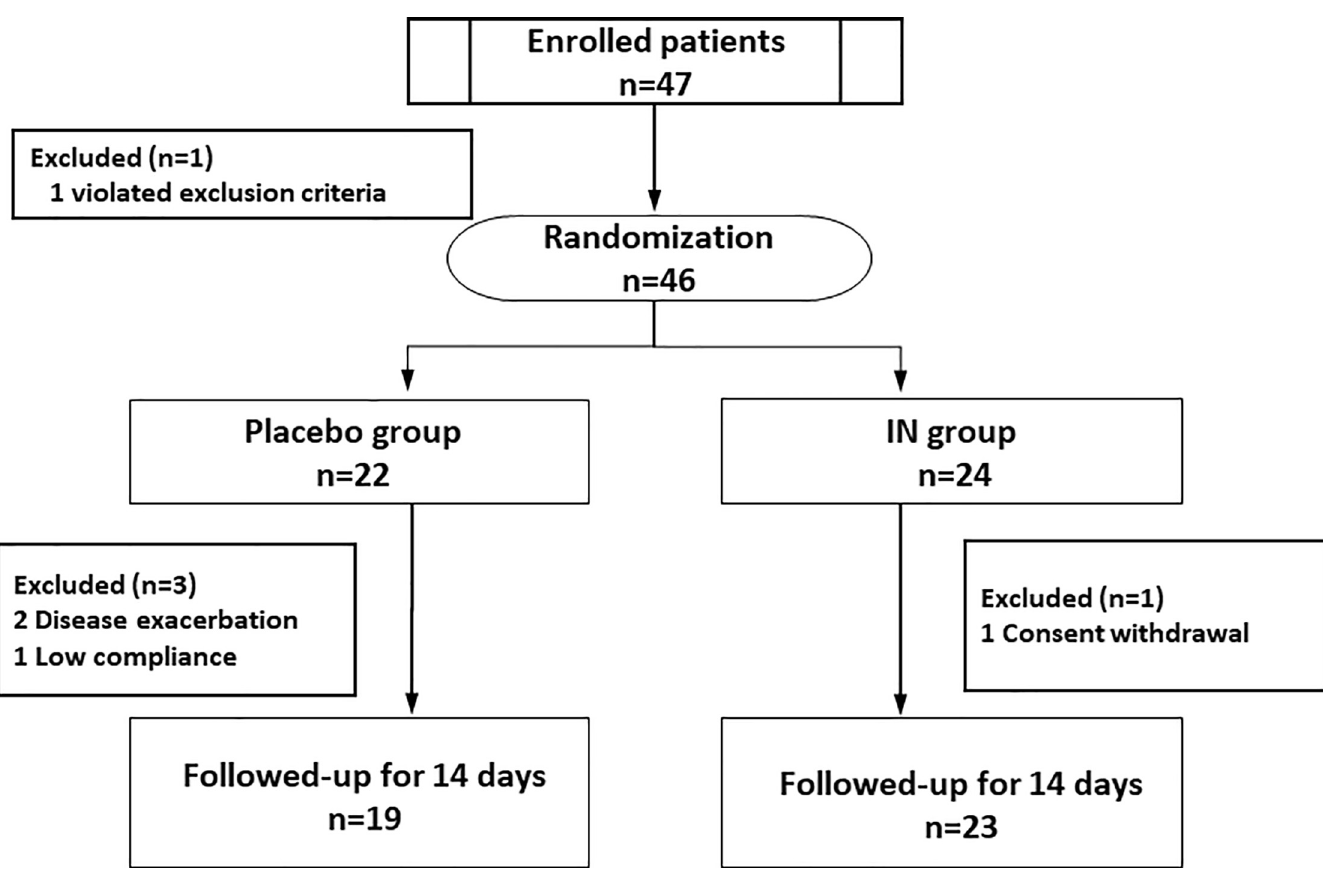
Fig 1. The research flow diagram. IN: indigo